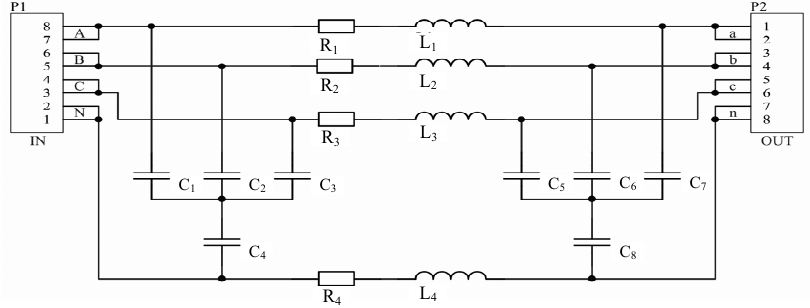
Figure 4. The schematic diagram of the three-phase distribution line module.